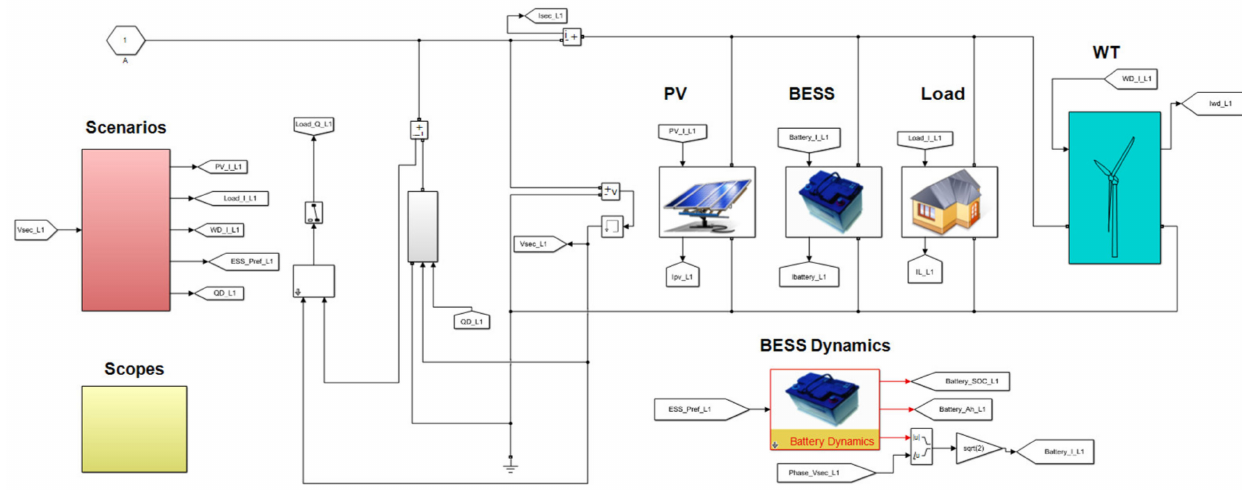
Figure 2. Modified complex load module at each